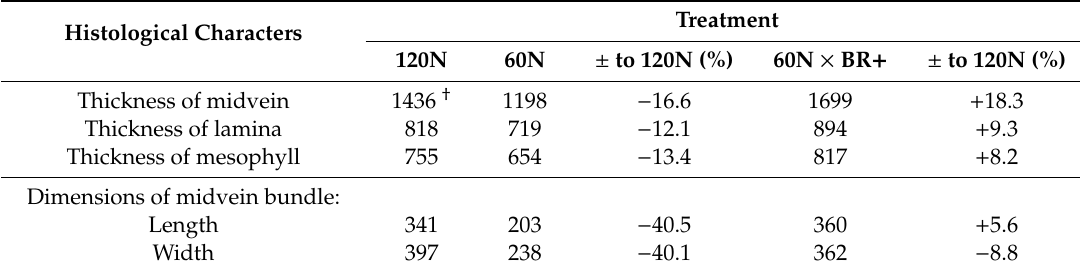
Table 5. Measurements ( µ m) of histological characters in transverse sections of leaf blade taken from the middle part of Egyptian henbane main stem as a ff ected by mineral nitrogen fertilizer (N) and Rhizobacterein biofertilizer